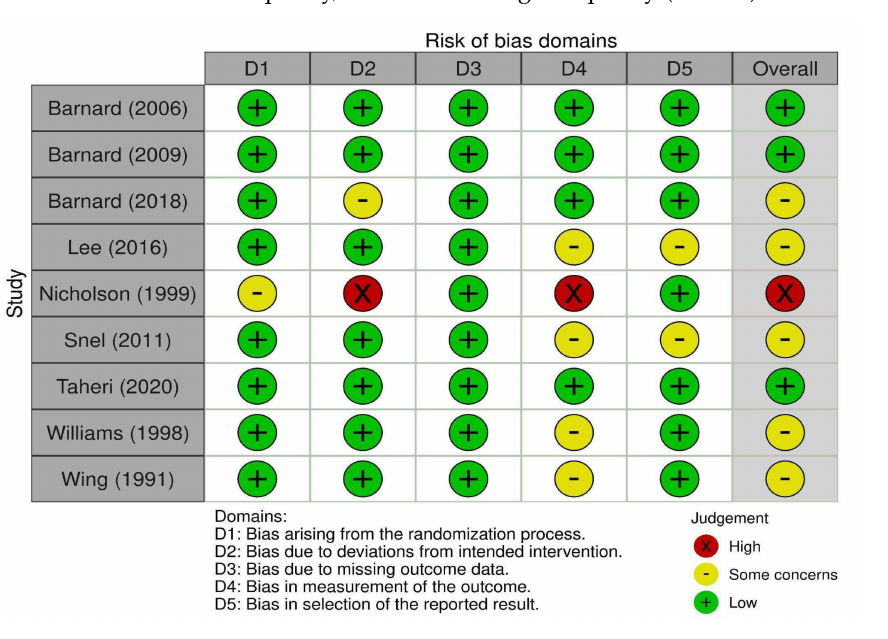
Figure 2. Risk of bias presented using Cochrane RoB 2 tool for the randomized controlled trials